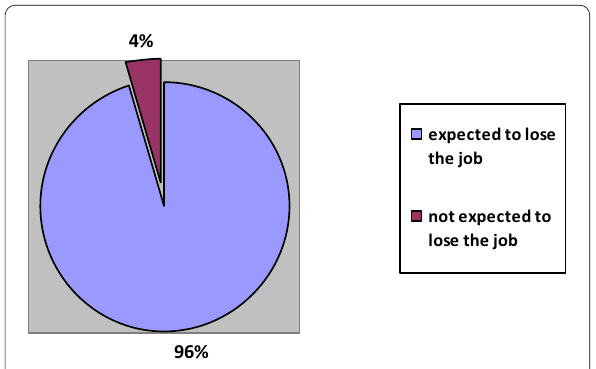
Fig. 8 Percentages of households who expected to lose their job